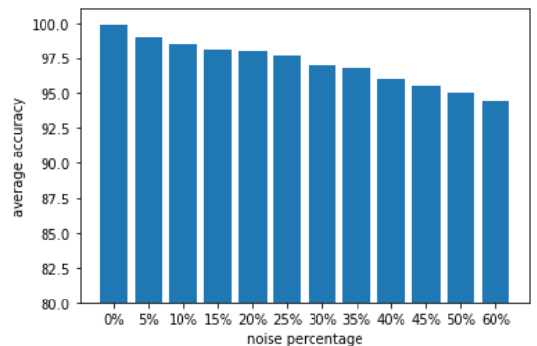
Figure 4. White Gaussian noise percentage vs. average accuracy over SVM, RF, KNN and bagging classifier .